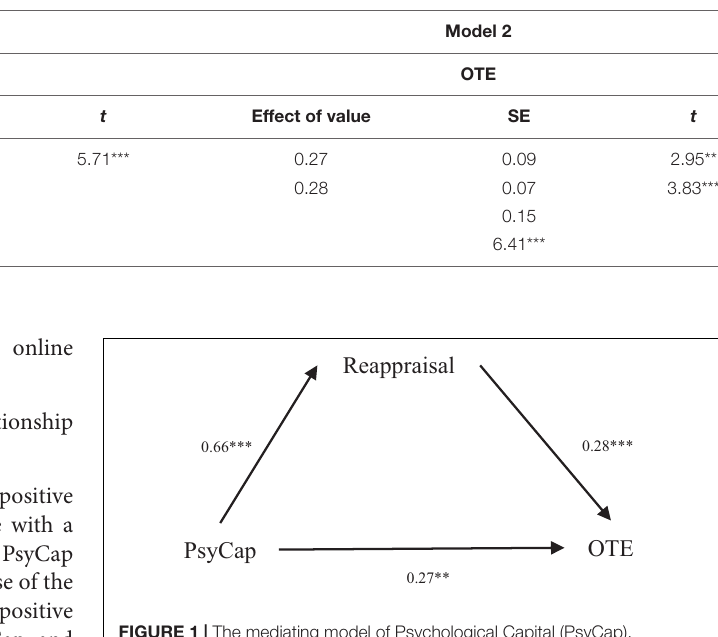
TABLE 3 | Test of mediation effect.